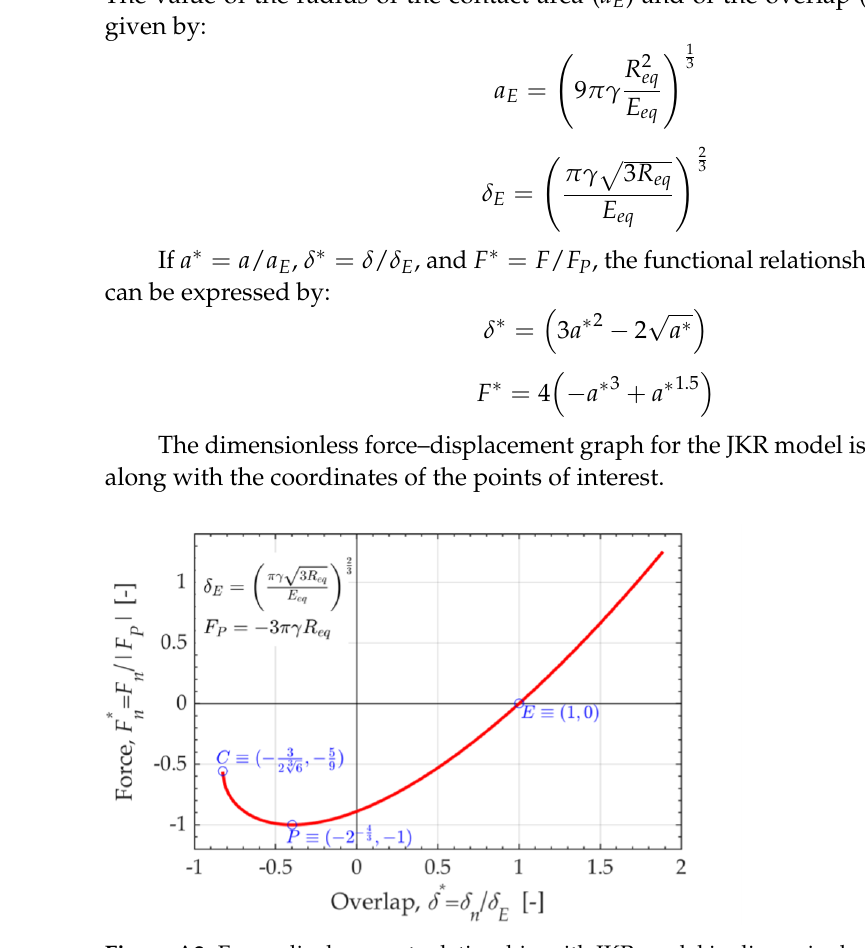
Figure A2. Force–displacement relationship with JKR model in dimensionless